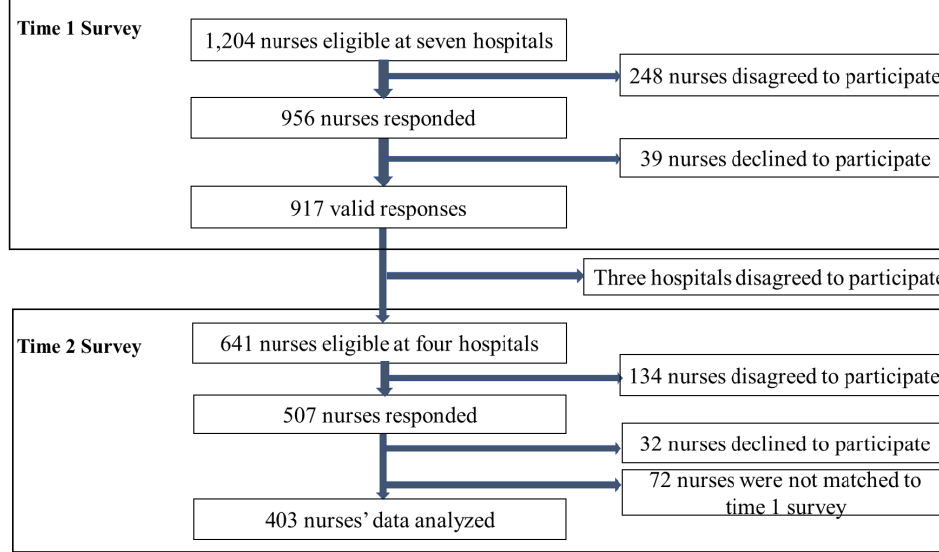
Figure 1. Hypothesized model.